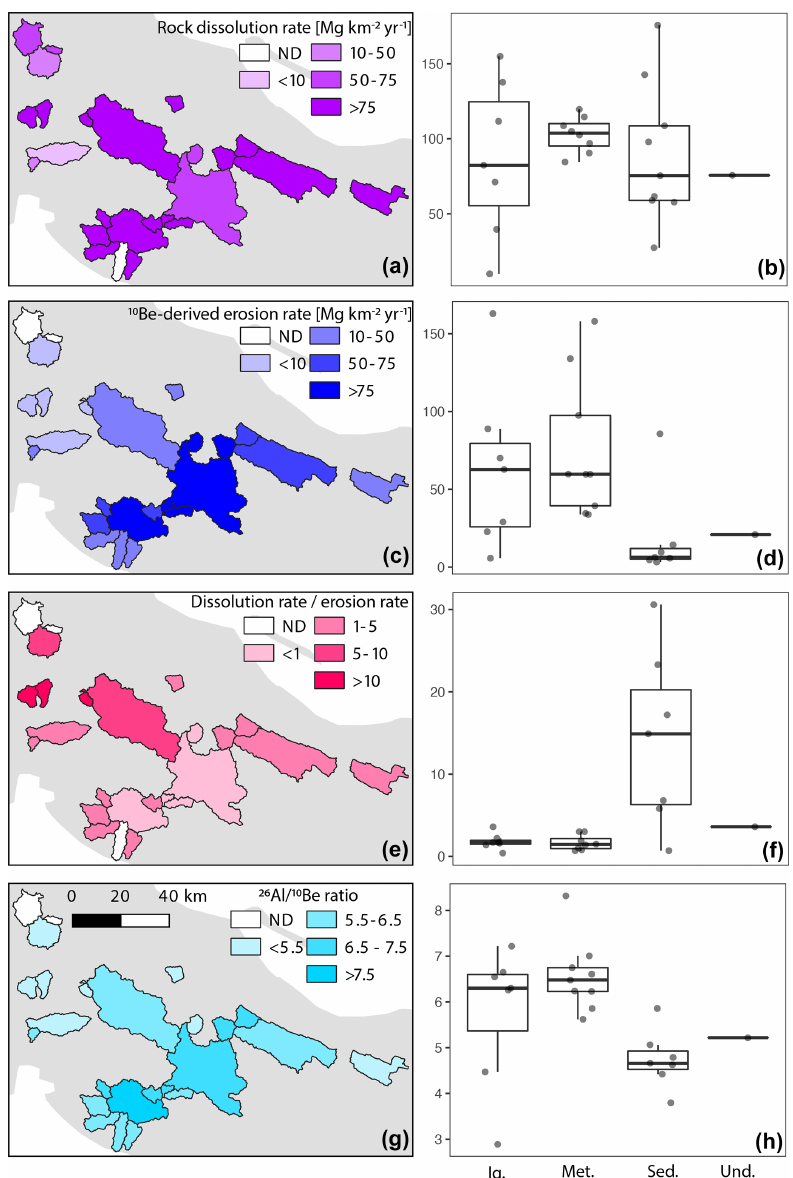
Figure 3. Maps showing rates of landscape change and isotopic data for each study watershed. (a, b) Rock dissolution rates. (c, d) 10 Be- derived erosion rates. In both maps, darker colors in the basins indicate faster rates of landscape change. (e, f) Ratio between rock dissolution rates and 10 Be-derived erosion rates; darker colors indicate larger ratios. (g, h) 26 Al / 10 Be ratio. Darker colors are higher ratios. Box plots show the maximum and minimum values in the lines extending from the box; the upper side of the box represents the upper quartile, the line inside the box represents the median value, and the bottom of the box represents the lower quartile. Y -axis units are the same as shown in the corresponding map